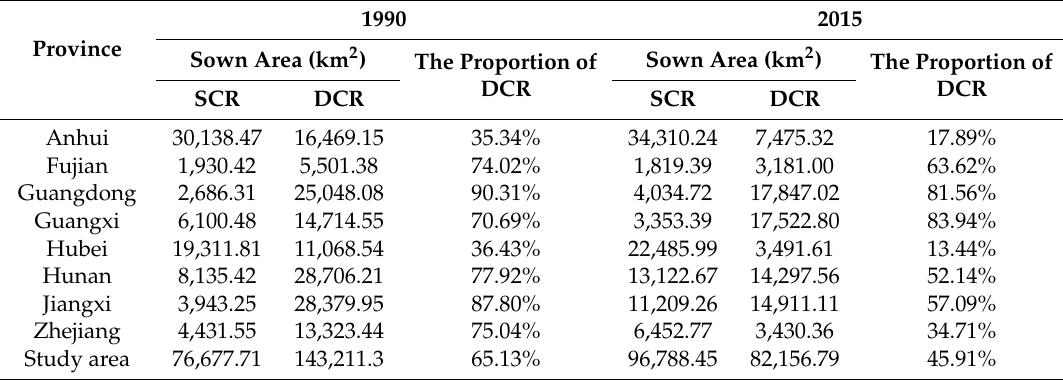
Table 2. Variations in rice cropping systems at the provincial scale in Southern China from 1990 to